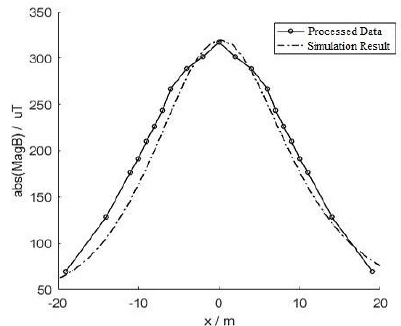
Figure 8. Comparison of simulation result and processed data.